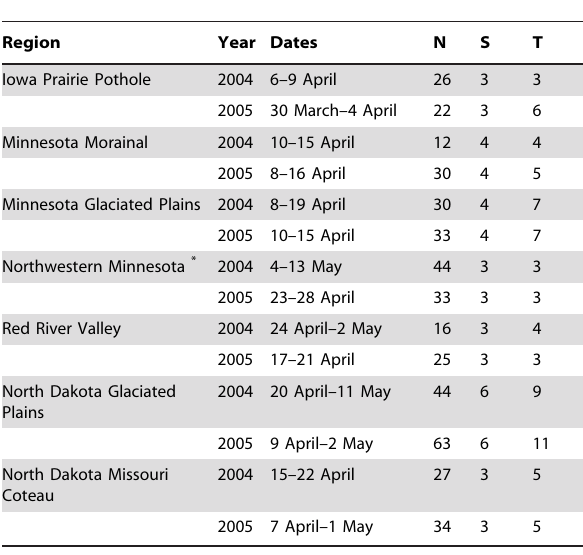
*Fixed collection sites (same each year).